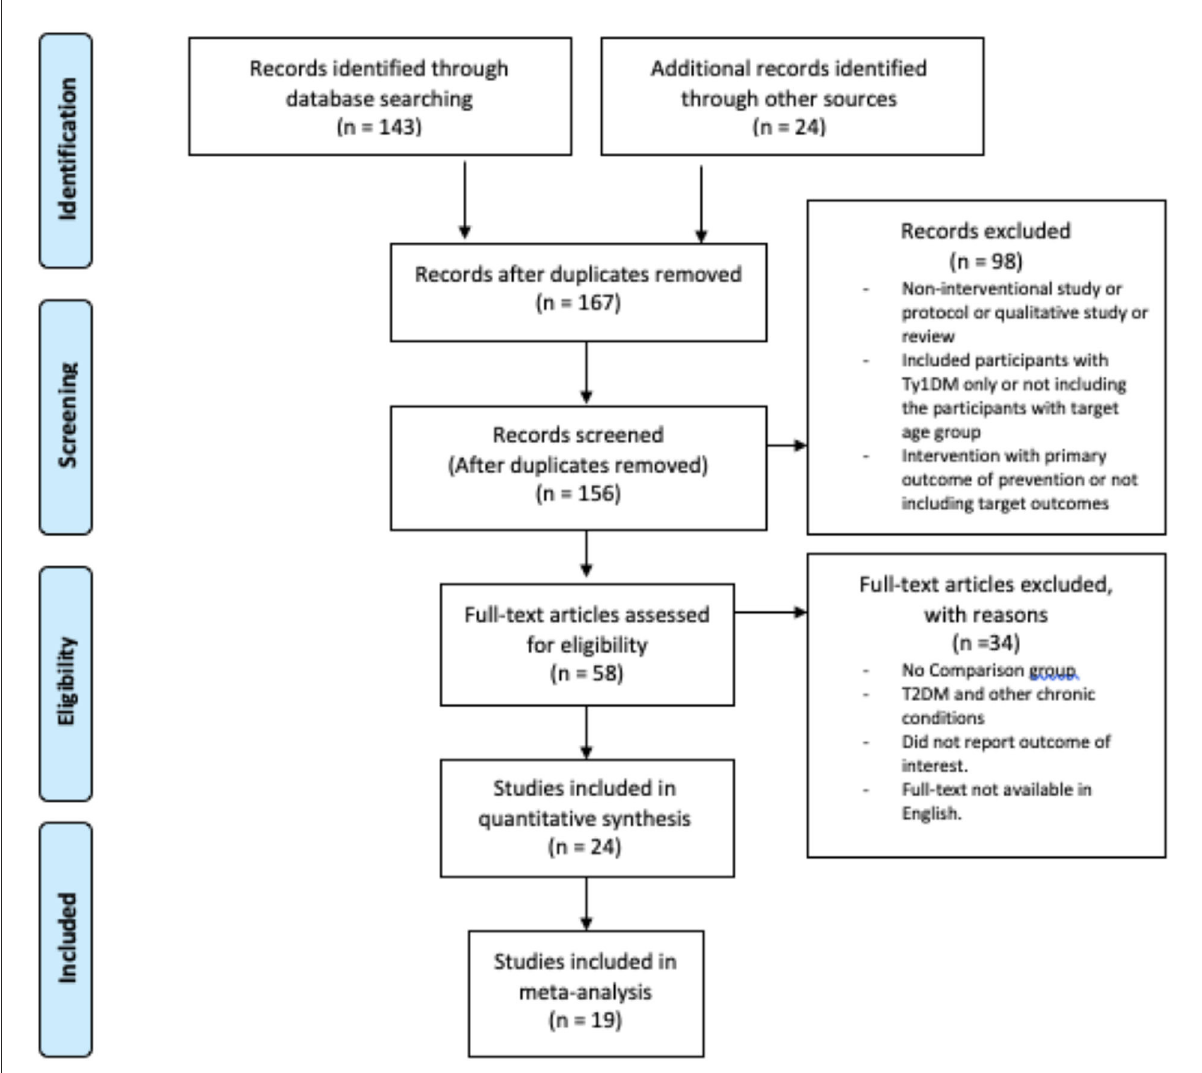
FIGURE1 PRISMA flow chart for study selection and reasons for